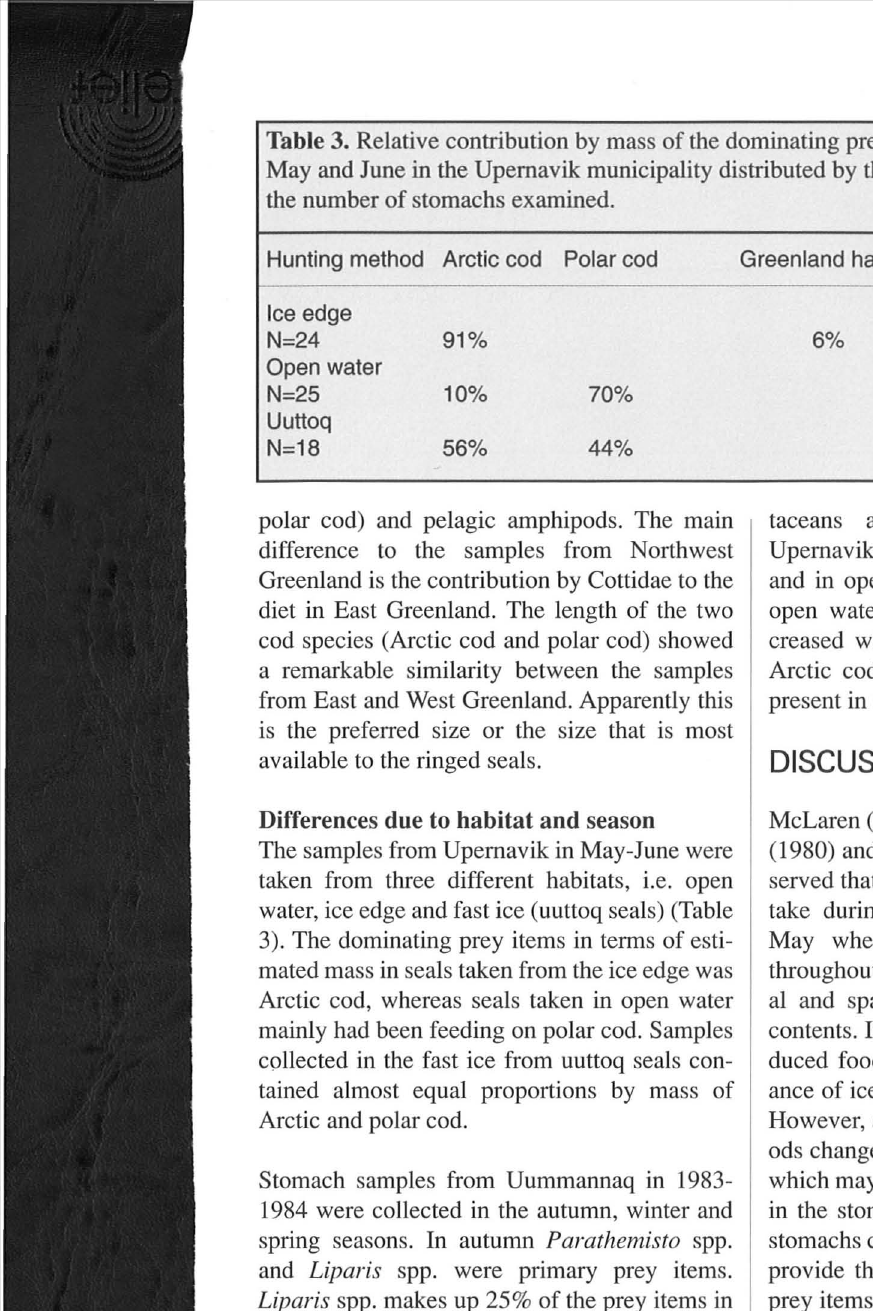
Table 3. Relative contribution by mass of the dominating prey items in the ringed seal diets in May and June in the Upemavik municipality distributed by three hunting methods. N indicates the number of stomachs